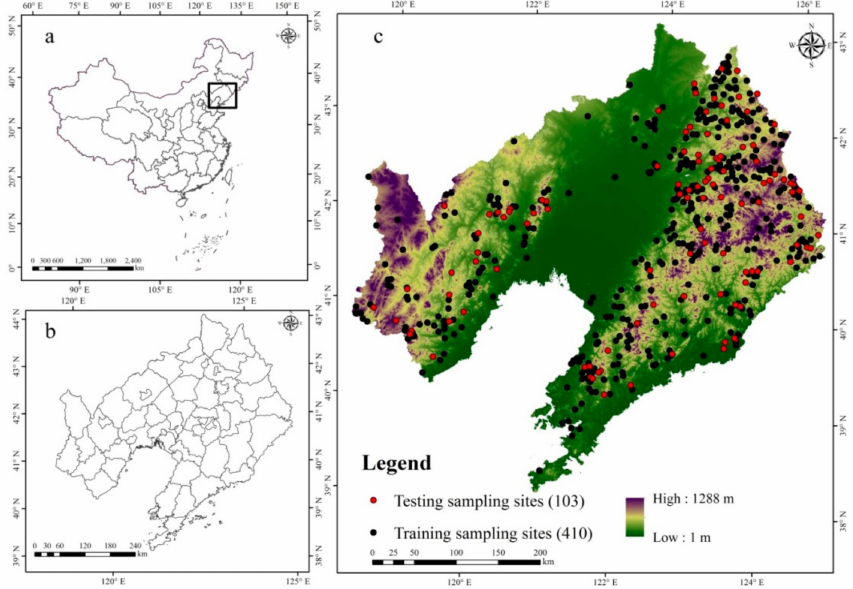
Figure 1. Soil sampling locations in digital elevation model map ( c ) at a 30 m spatial resolution in Liaoning Province ( b ) of China ( a